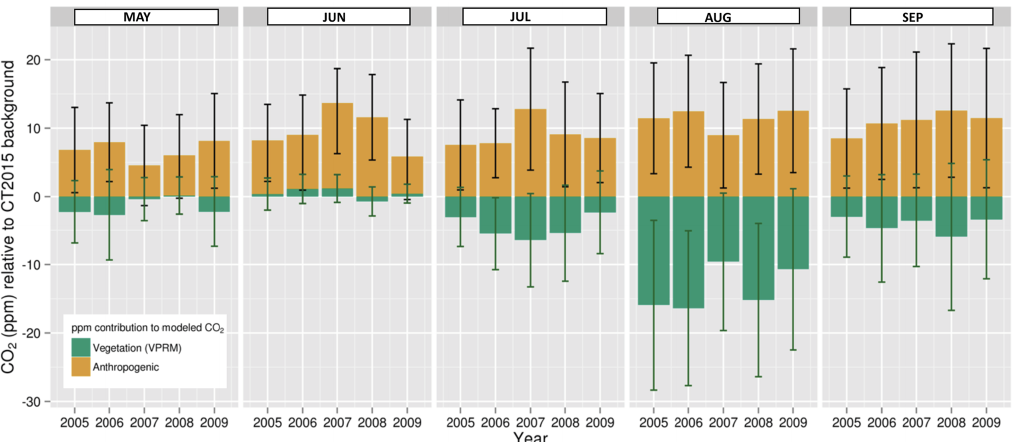
Figure 10. Modeled mean monthly contribution (ppm) to Miyun CO 2 from vegetation (VPRM-CHINA) and anthropogenic (ZHAO) sources, relative to advected CT2015 background concentrations during the regional growing season (MJJAS). Error bars represent 1 σ of monthly averages (green: VPRM-CHINA vegetation; black: ZHAO anthropogenic). Negative values represent depletion from CT2015 background; positive values represent